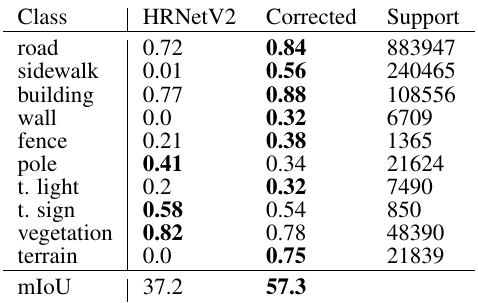
Figure 6. Examples for successfully corrected predictions after retraining. The figure shows, from left to right, the input image, the uncorrected prediction, the corrected prediction, and the manually labelled ground thruth. Table 2. Results on the test set before (HRNetV2) and after correcting (Corrected) multi view